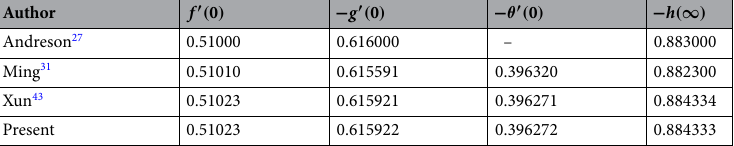
Table 1. Numerical results of f ′ ( 0 ) , g ′ ( 0 ) , θ ′ ( 0 ) and 0 and Ma , K , K 1 , K 2 , k m =